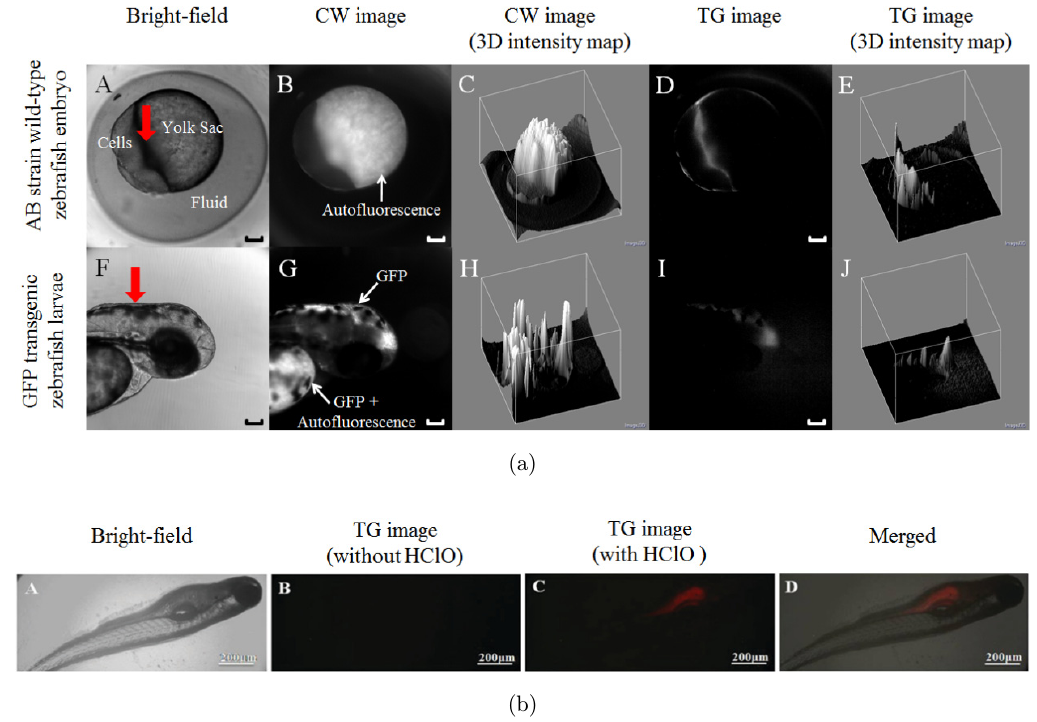
Fig. 11. Comparison of CW and TG images of zebra¯sh embryos and larvae in vivo . (a) Si-based NPs as long-lived °uorescent probes were injected at the position indicated by the red arrow in A and F. Scale bar: 50 (cid:3) m. (b) Mito-NPSTTA-Eu 3 þ was used as a luminescent probe for TG luminescence detection of HClO in zebra¯sh larvae. D is merged image of A and C. Reprinted with permission from Refs. 20 and 74.